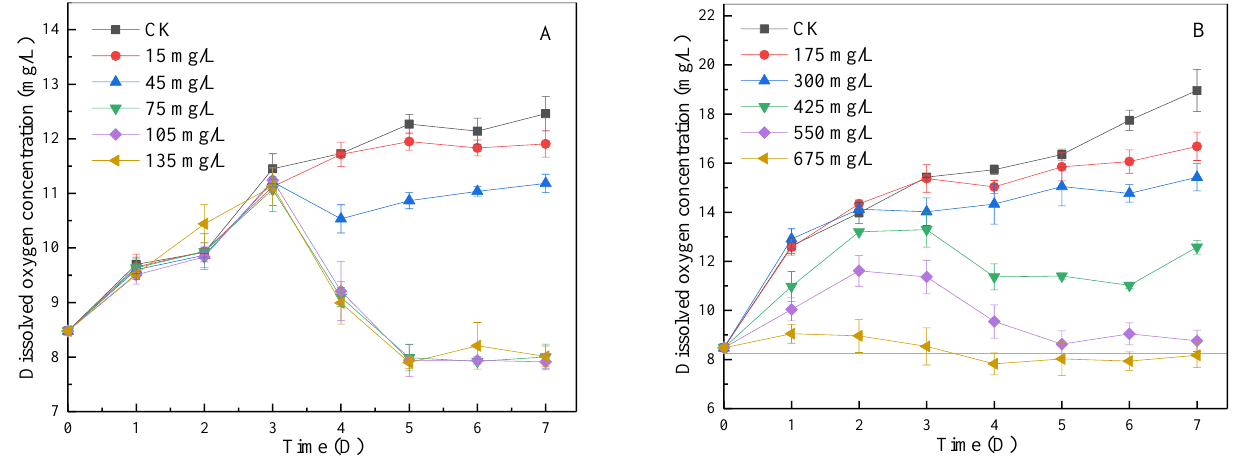
Figure 6. The effect of SA-CS on the concentration of DO in algal liquid at lag phase and log phase: ( A ) the effect of SA-CS on DO at lag phase; ( B ) the effect of SA-CS on DO at log phase. The rise in DO in the initial stage was caused by the fact that the oxygen production capacity was greater than the oxygen consumption capacity when there was little or no inhibition. The decrease in DO concentration is mainly due to the inhibition of photosynthesis by SA, which reduces the oxygen production of algae [41]. At the same time, the reduction of algae quantity will also lead to the reduction in oxygen production capacity and will also reduce the DO concentration. In neither the log phase nor lag phase, reduction of the DO concentration is limited to the part that exceeds the saturated dissolved oxygen, and the concentration of DO in water remains near the saturated dissolved oxygen concentration, which has little impact on the environment.